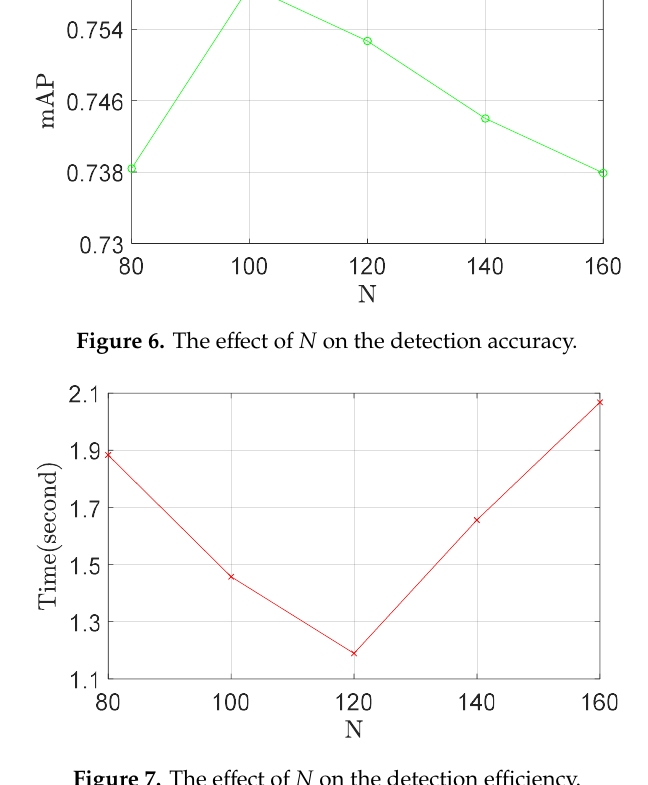
Figure 7. The effect of